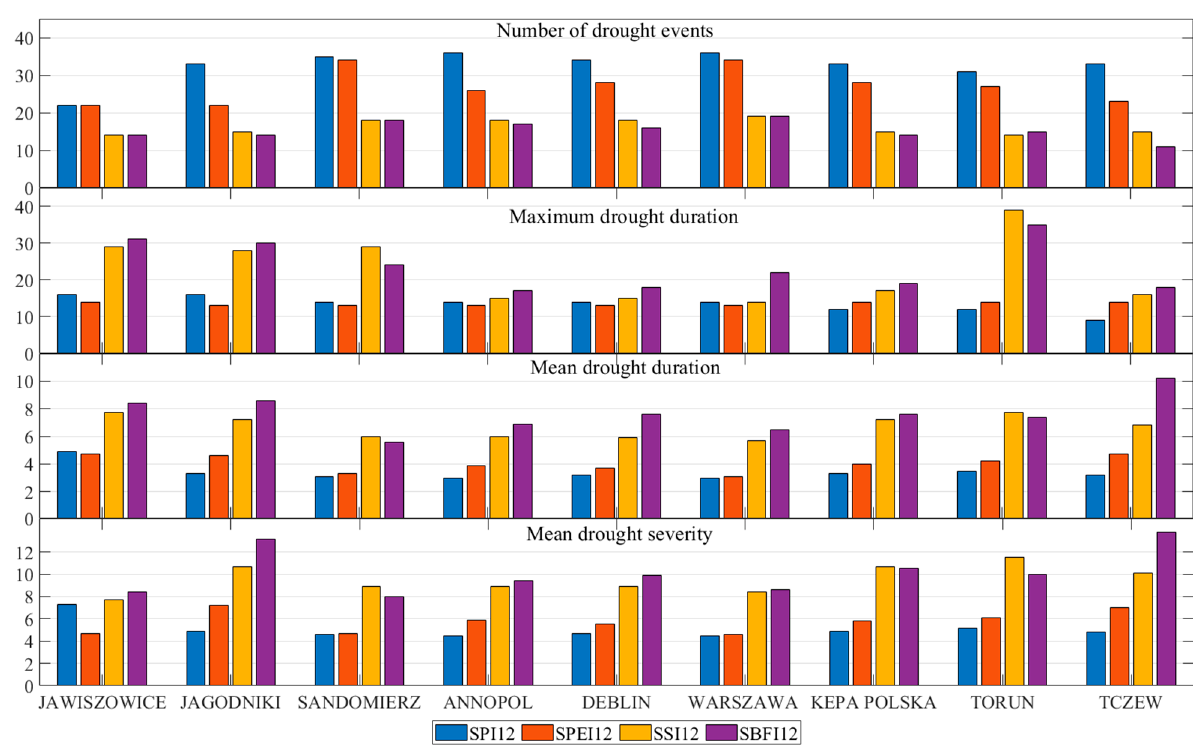
Figure 11. Comparison of drought characteristics, including the number of drought events, maximum drought duration (months), mean drought duration (months), and mean drought severity based on four drought indices for the 1961–2017 period for nine sub-basins within the Vistula basin.